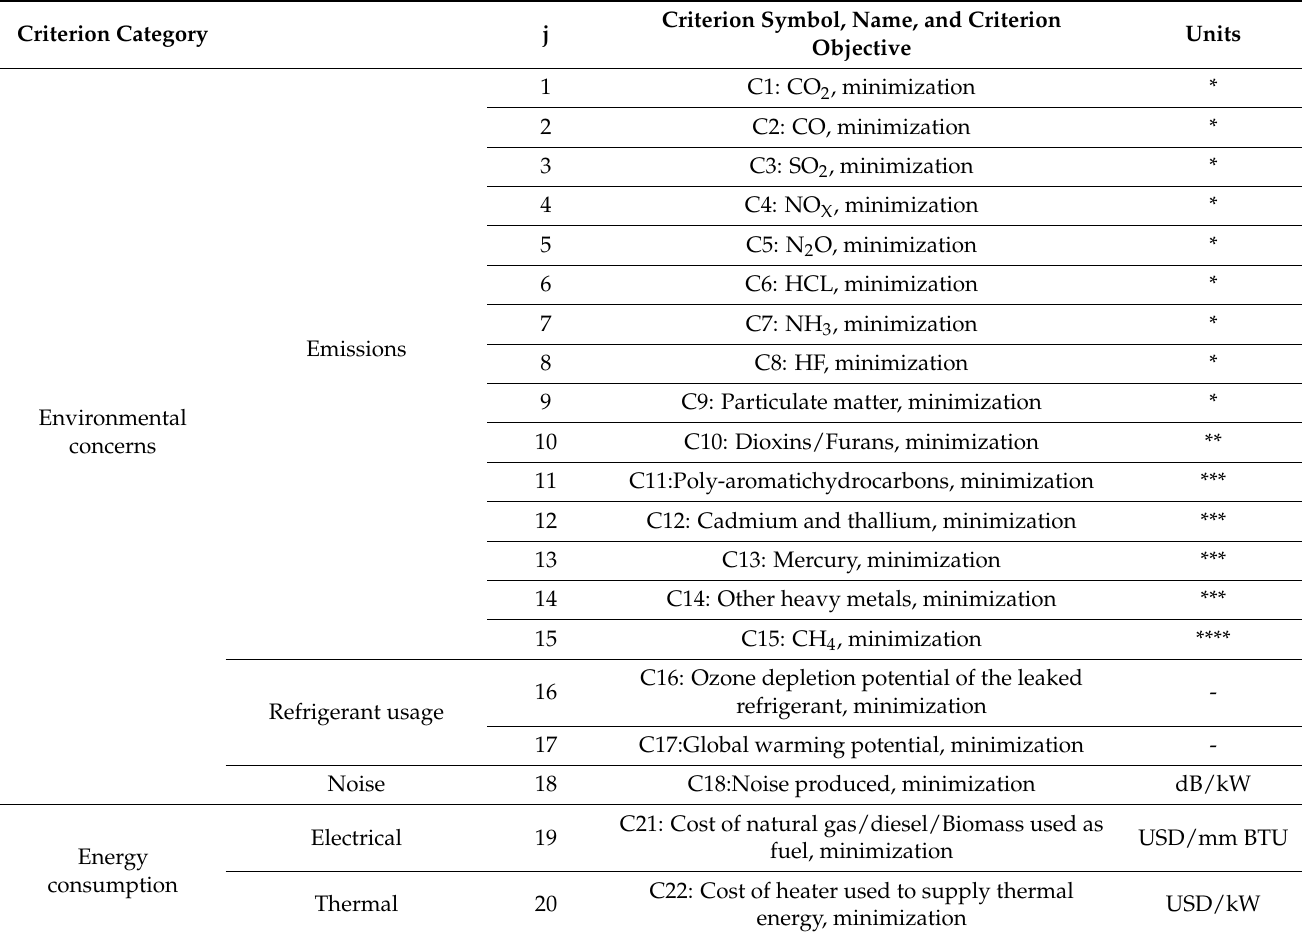
Table 1. Criteria categories and their